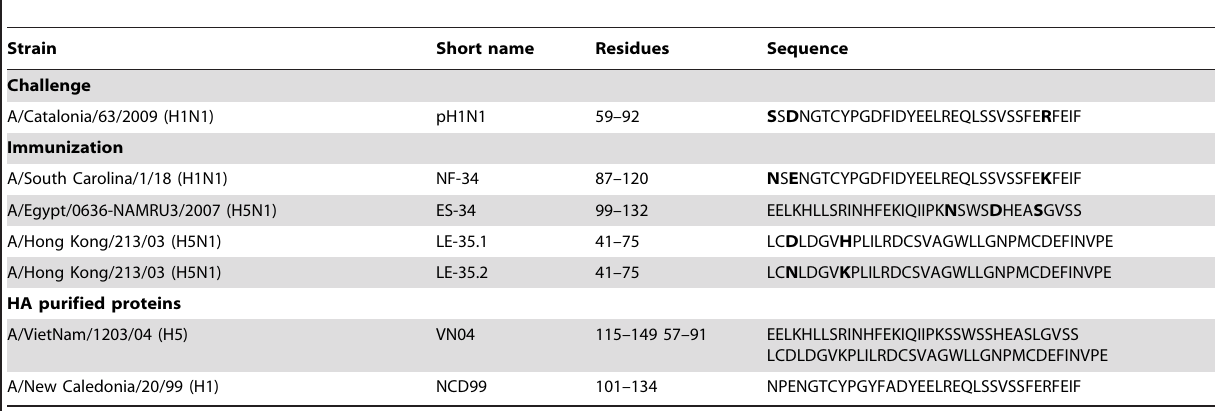
Table 1. Amino acid sequences from the peptides used for immunization compared to the homologue sequence of the HA receptor recognition domain of the challenging strain (pH1N1) and the HA purified proteins used for the serologic tests.